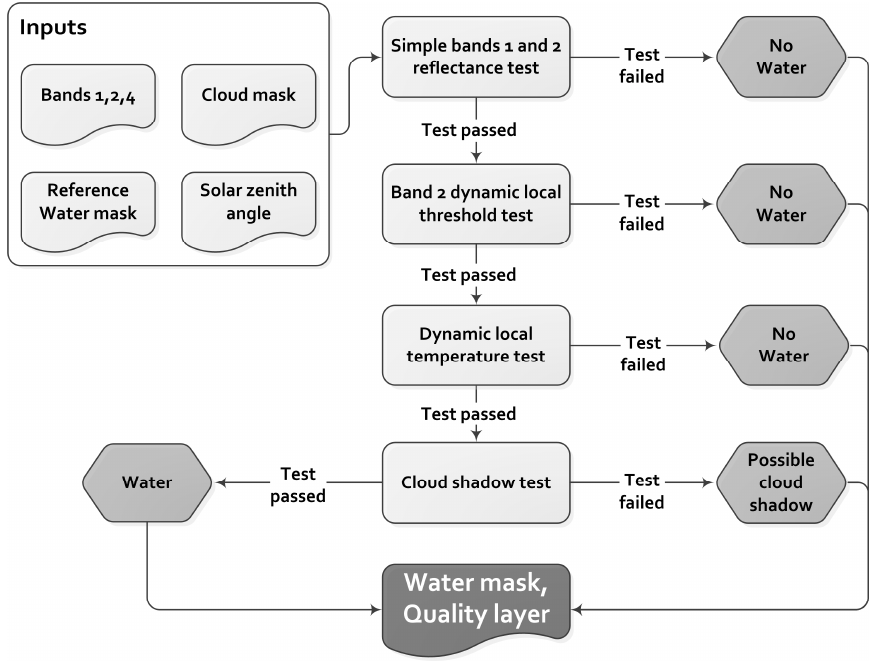
Figure 5. Flowchart of the TIMELINE Water Mask Processor.